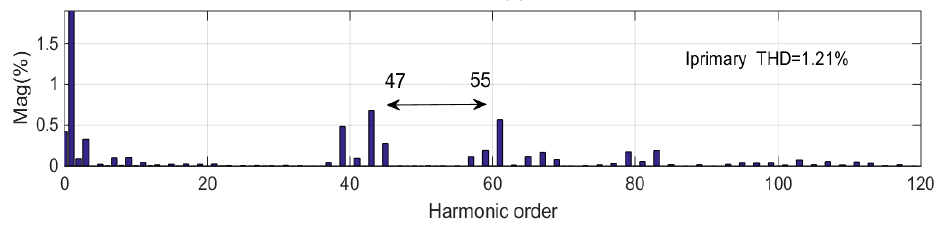
Figure 18. Fourier analysis of transformer primary current.